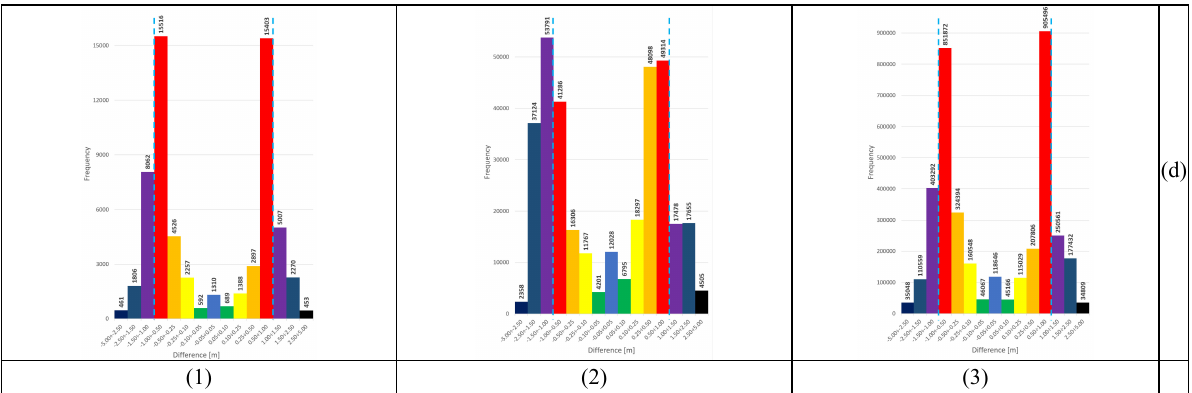
Figure 10 . Histograms of the 12 computed heat maps in predefined ranges with the inscribed ISOK accuracy requirements. Description of an image matrix Rows: (a) and (b) – Geoportal model, (c) and (d) – SketchUp